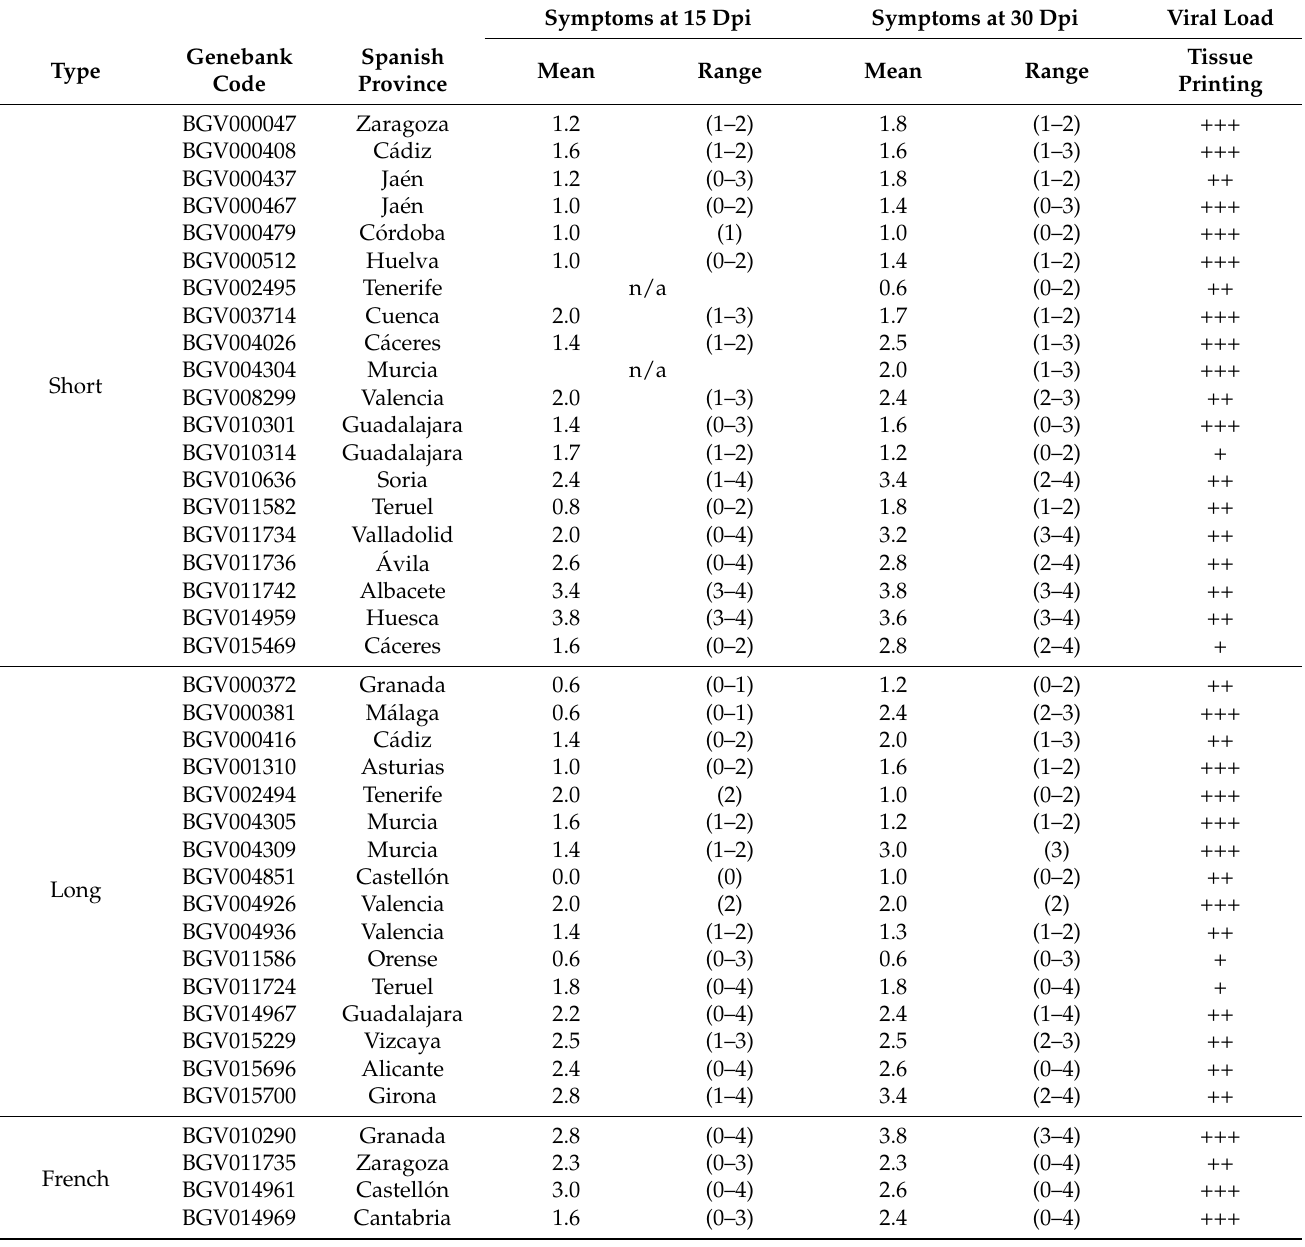
Table 1. Response of Spanish landraces of C. sativus to the mechanical inoculation with ToLCNDV. Mean and range of symptoms scored in plants per genotype (at 15 and 30 dpi) according to the scale: 0, absence of symptoms; 1, mild symptoms; 2, moderate symptoms; 3, severe symptoms; 4, very severe symptoms or plant death. Mean score of viral load detected in each plant of the assayed accessions by tissue printing at 15 dpi according to the scale of high (+++), intermediate (++), low (+), or absent (-) viral accumulation. Data not available are shown as